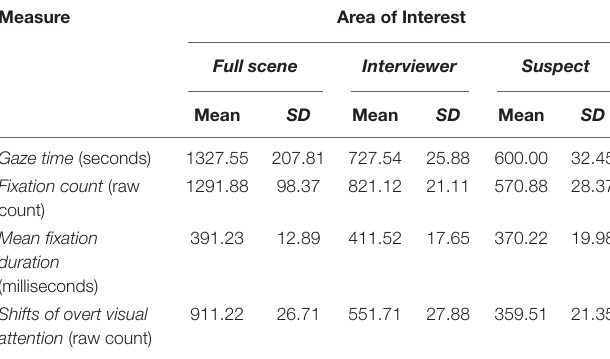
TABLE 2 | Summary descriptive statistics for eye tracking measures across areas of